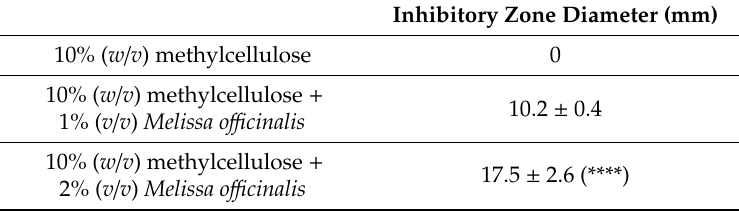
Table 1. Inhibitory zone diameters of 10% ( w / v ) methylcellulose hydrogels with or without 1 or